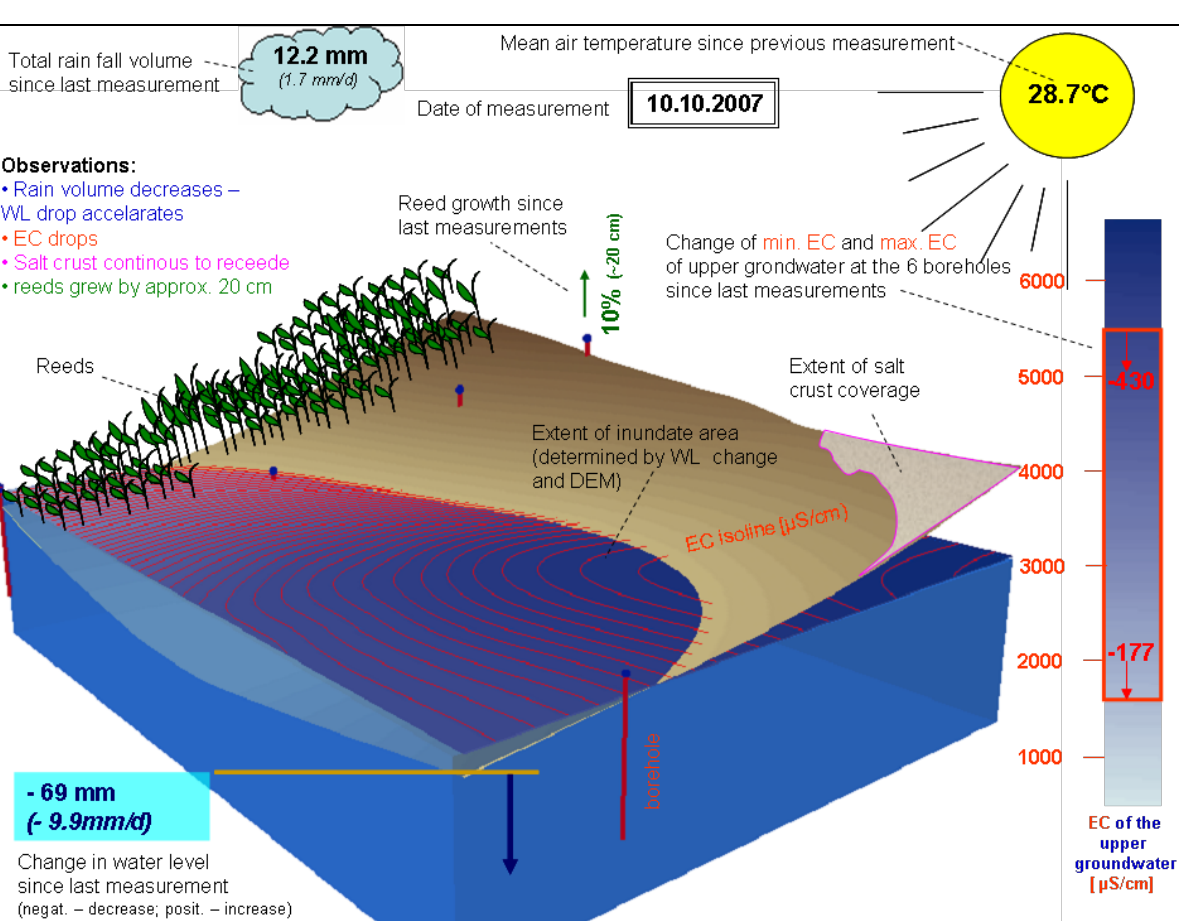
Figure 16. An example of a PowerPoint slide depicting the temporal change of water level and EC of alluvial groundwater at the borehole transect at portion 7 for a certain date of measurement. Parameters of possible relevance such as rainfall, air temperature, vegetation growth and salt crust coverage are also displayed. This slide represents 1 in a series of approximately 40 slides that cover all measurements taken over the 11 month observation period. Displaying all slides in rapid succession allows the viewer to perceive discrete results in an almost uninterrupted time-lapse camera like fashion. Superimposed onto DEM associated spatial changes such as growing or shrinking of inundated areas are displayed in a (quasi)